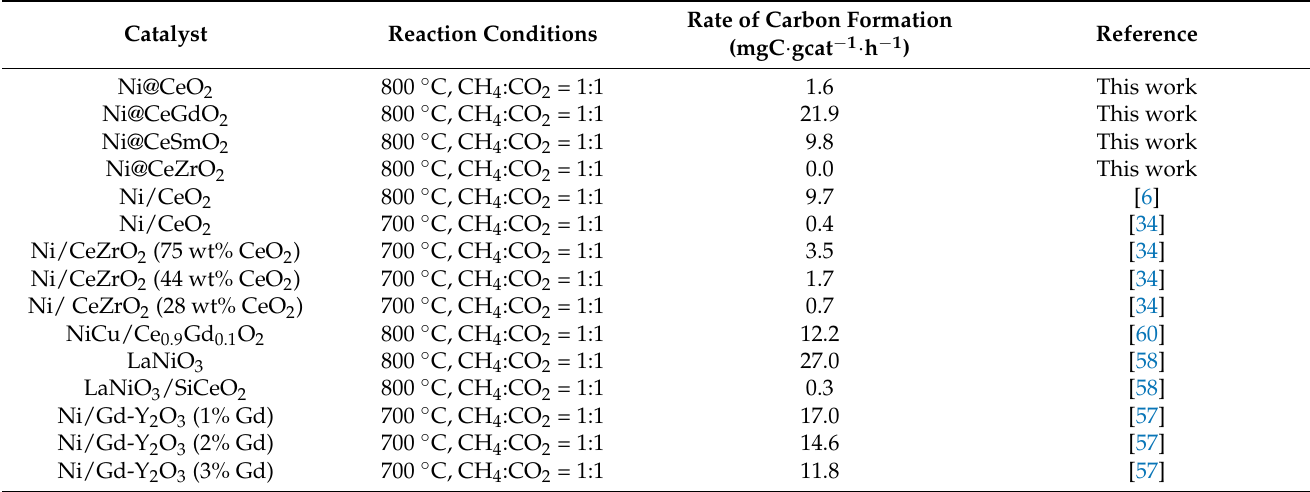
Table 4. Rate of carbon formation obtained by TGA in our work compared to the data obtained from